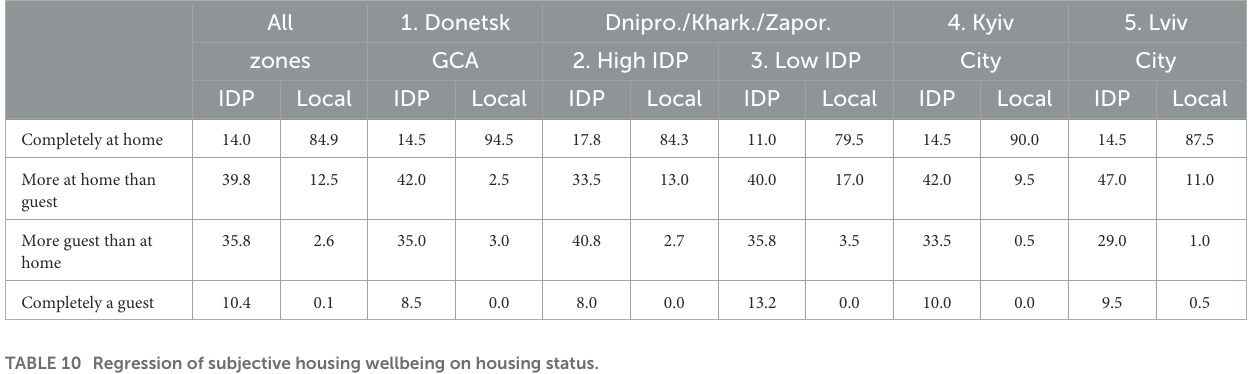
TABLE 10 Regression of subjective housing wellbeing on housing status. Housing satisfaction (ord.